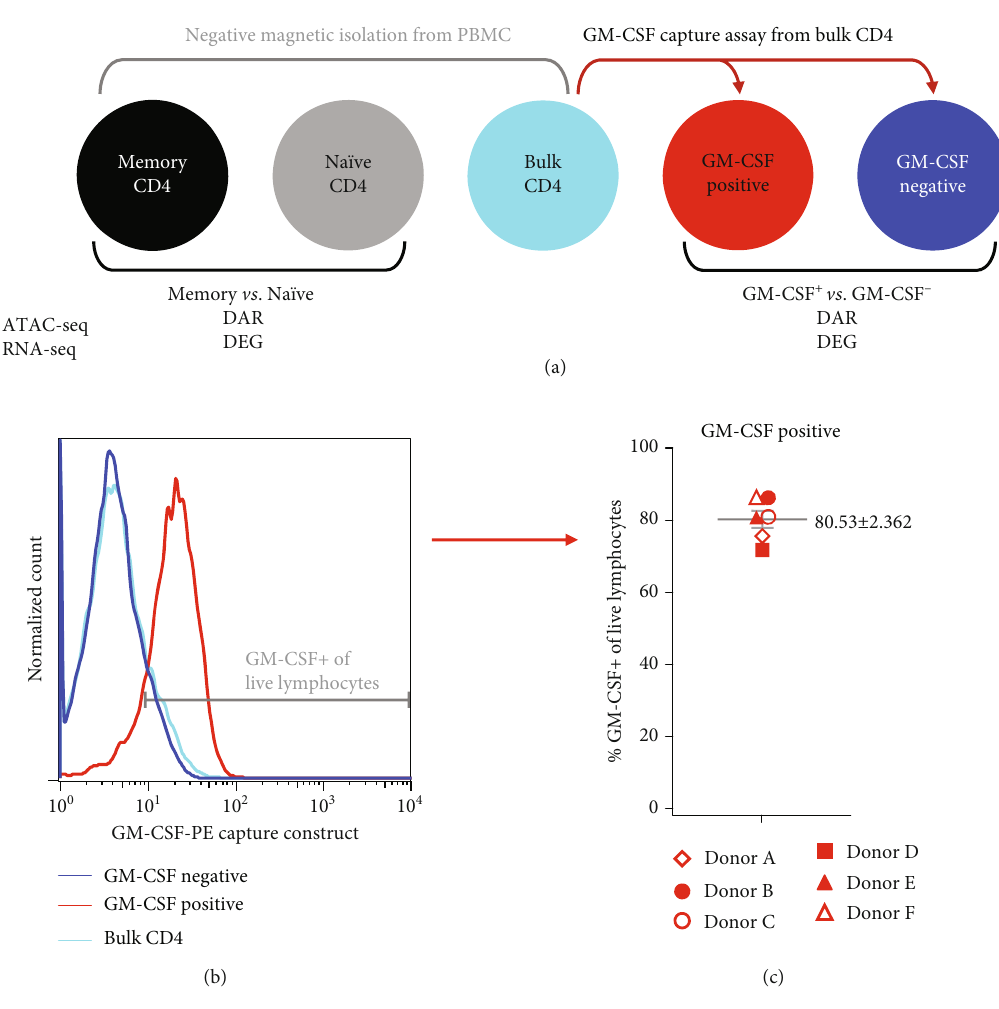
Figure 1: Experimental setup and quality control for human CD4 T cell transcriptome and chromatin accessibility analysis. (a) Human PBMCs for each donor were split in three fractions, and memory CD4 T cells, naïve CD4 T cells, and bulk (total) CD4 T cells were isolated in parallel by negative (untouched) magnetic isolation (cell purities; see Supplementary Figure S1). From bulk CD4 T cells, GM- CSF-secreting cells (GM-CSF positive) were captured and the negative fraction was used as the corresponding GM-CSF-negative population. The fi ve indicated cell populations were used for molecular pro fi ling by ATAC-seq and RNA-seq. Di ff erentially accessible DNA regions (DAR) and di ff erentially expressed genes (DEG) were determined for the comparison of memory versus naïve CD4 T cells and for GM-CSF-positive versus GM-CSF-negative CD4 T cells, respectively. (b, c) High purity of isolated (captured) GM-CSF+ CD4 T cells was con fi rmed by fl ow cytometry. The histograms show the signal of the GM-CSF capture construct for the indicated cell populations, pregated on live singlet lymphocytes based on forward scatter, side scatter, and pulse width. Here, bulk CD4 T cells represent an aliquot taken after labeling with the GM-CSF-PE capture construct, but without further capture assay procedure. (b) shows a representative donor and (c) shows summarized data for n = 6 donors from 4 independent experiments (mean and SEM are indicated in grey). Each donor is represented by a symbol; same symbol shape (but fi lled or un fi lled) indicates donors processed within the same